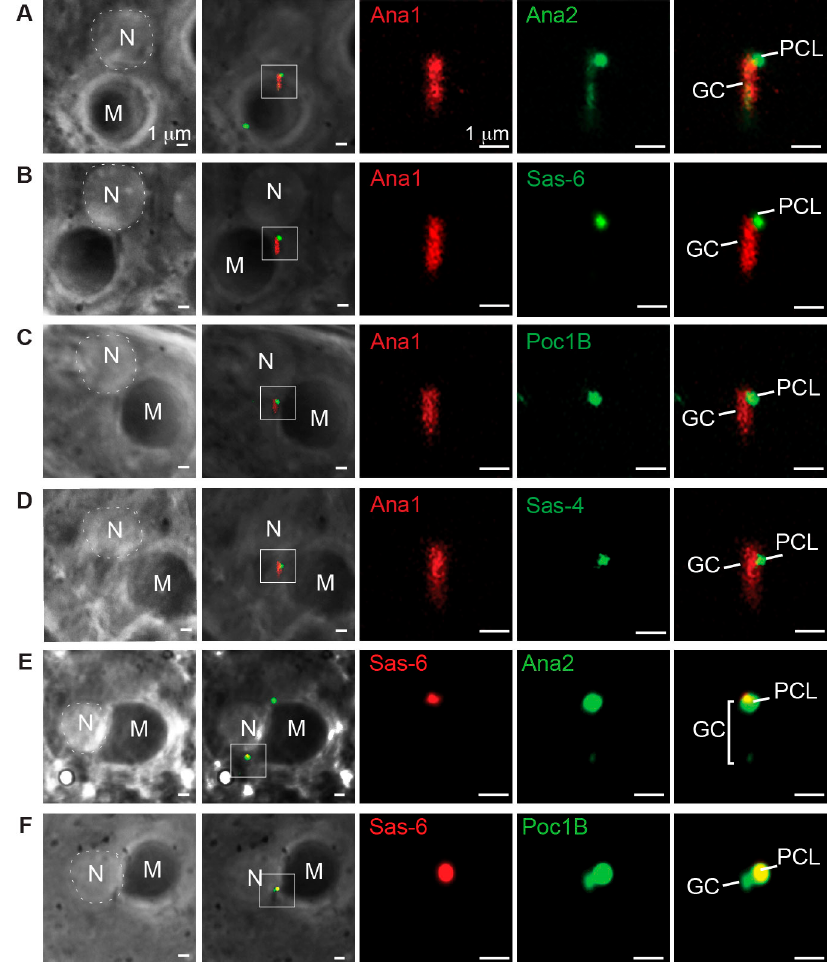
Figure 1. Poc1B is recruited during the initial stage of proximal centriole-like structure PCL formation. ( A – F ) Proteins localized at the centrioles in round spermatids. Low magnification images of phase contrast on the left panel showing the round shape of nucleus (N) and Mitochondria derivatives (M) relative to the centrioles. High magnification images of centrioles on the right panels. The magnified region is marked with the white box. Phase contrast images were used to determine the same stage of round spermatids for each protein. All images were obtained by live cell imaging. ( A ) Ana2GFP and Ana1tdtomato label the giant centriole (GC), but only Ana2GFP is enriched at the PCL. ( B ) Sas6GFP and Ana1tdtomato label the GC, but only Sas6GFP is enriched at the PCL. ( C ) Ana1tdtomato label the GC, but only gPoc1BGFP is enriched at the PCL. ( D ) Ana1tdtomato labels the GC, but only Sas-4GFP labels the PCL. ( E ) Ana2GFP and Sas6RFP are colocalized at the PCL. ( F ) Poc1BGFP and Sas6RFP are colocalized at the PCL.